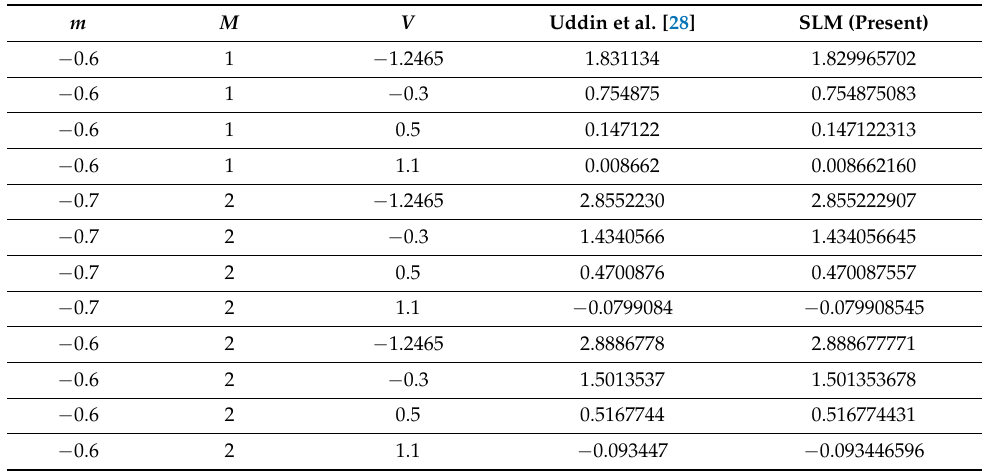
Table 2. Comparison of skin friction for different values of M , V and m .